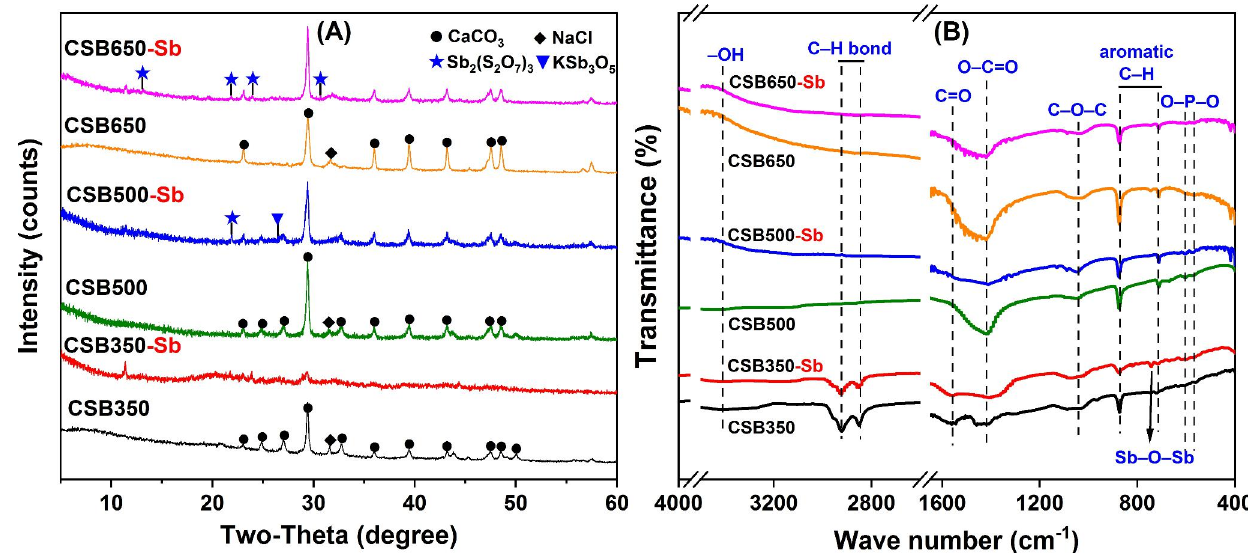
Fig. 6 X-ray diffraction (XRD) patterns (A) and FTIR spectra (B) of crawfish shell biochar (CSB) pyrolyzed at 350 ° C (CSB350), 500 ° C (CSB500), and 650 ° C (CSB650) before and after Sb(III) adsorption